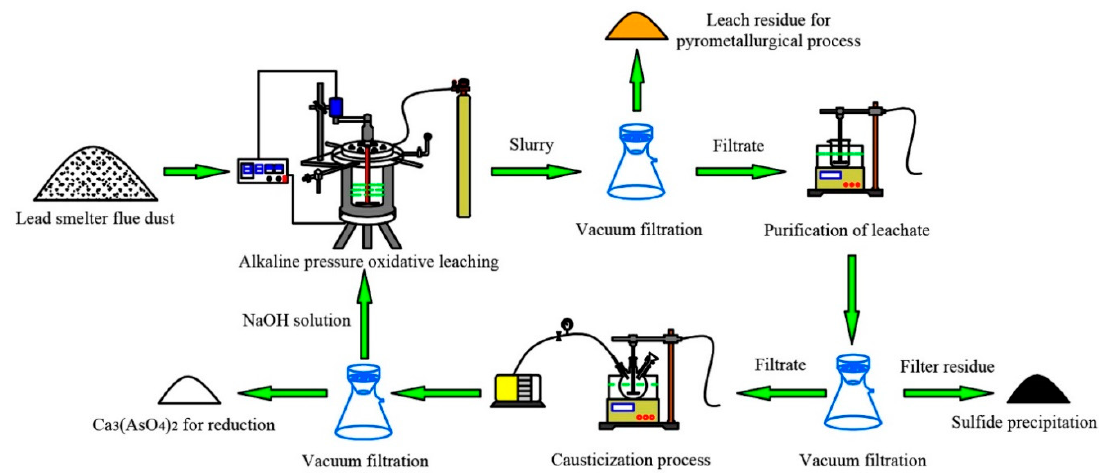
Figure 3. The experimental schematic diagram of the proposed process.